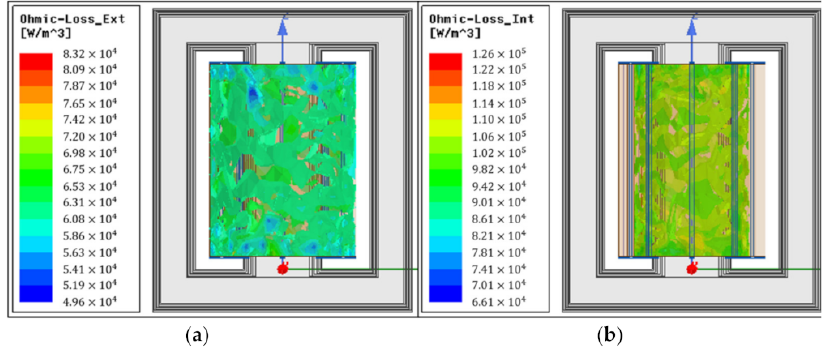
Figure 9. Ohmic losses during nominal operation: ( a ) in external winding, ( b ) in internal